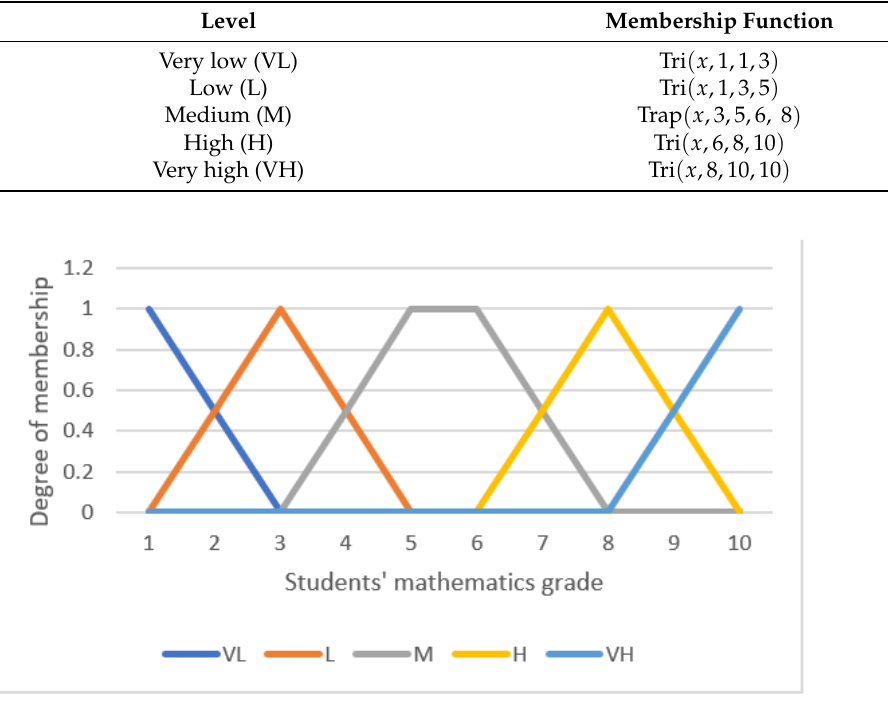
Figure 3. The utilized model for the assessment of students’ mathematical knowledge.